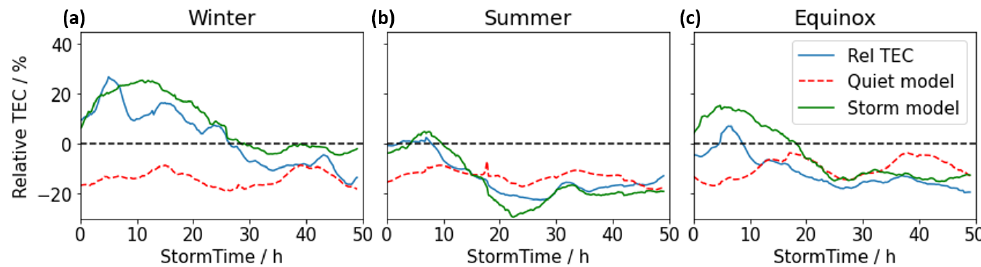
Figure 9. The performance of the quiet-time and the storm-time model in relative TEC as a function of storm time (averaged over complete region) for the test data set (2015 and 2020) during winter ( a ), summer ( b ) and equinox ( c ). The classification into seasons was performed according to the DOY listed in Table